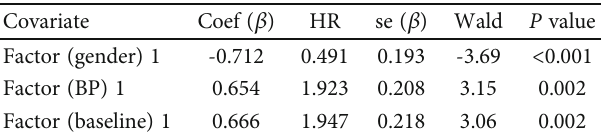
Table 6: The likelihood ratio and signi fi cance of the PH model. Covariate Coef ( β )